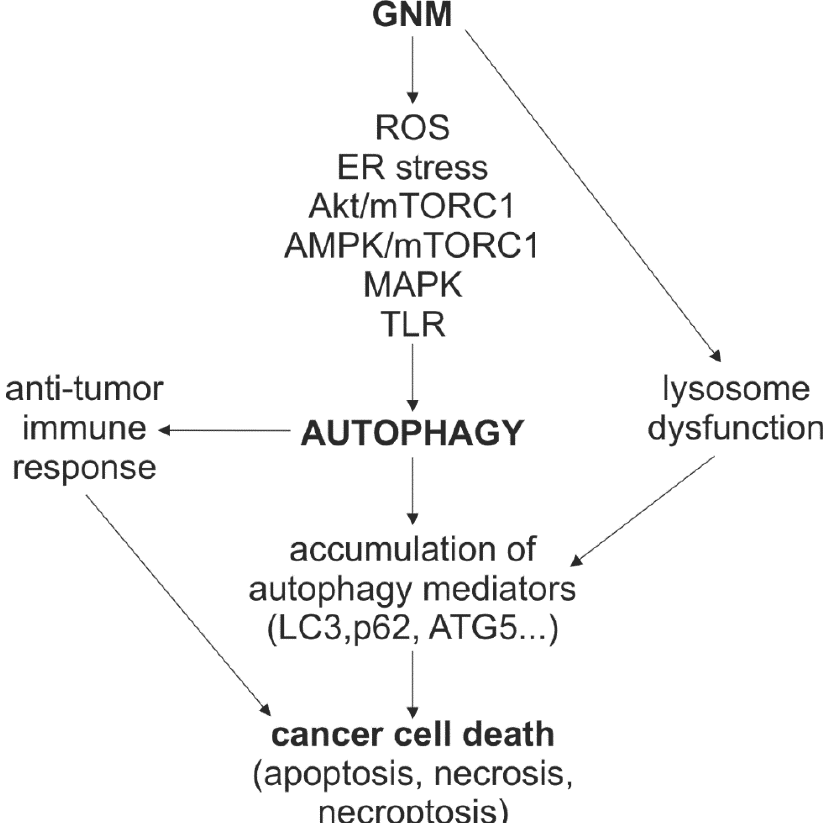
Figure 4. A schematic representation of the mechanisms and role of autophagy modulation in the anticancer action of GNM. GNM induce autophagy through oxidative/ER stress and AMPK/AKT/mTORC1, MAPK, or TLR signaling, but can simultaneously block autophagic flux by causing lysosomal dysfunction. This leads to accumulation of autophagic mediators such as LC3, p62, and ATG5, which participate in apoptotic, necrotic, or necroptotic death of tumor cells. GNM-induced autophagy could also modulate anti-tumor immune responses. AMPK, AMP-activated protein kinase; ATG, autophagy-related; ER, endoplasmic reticulum; GNM, graphene nanomaterials; LC3, microtubule-associated light chain 3; MAPK, mitogen-activated protein kinases; mTOR, mechanistic target of rapamycin complex 1; ROS, reactive oxygen species; TLR, Toll-like receptors.